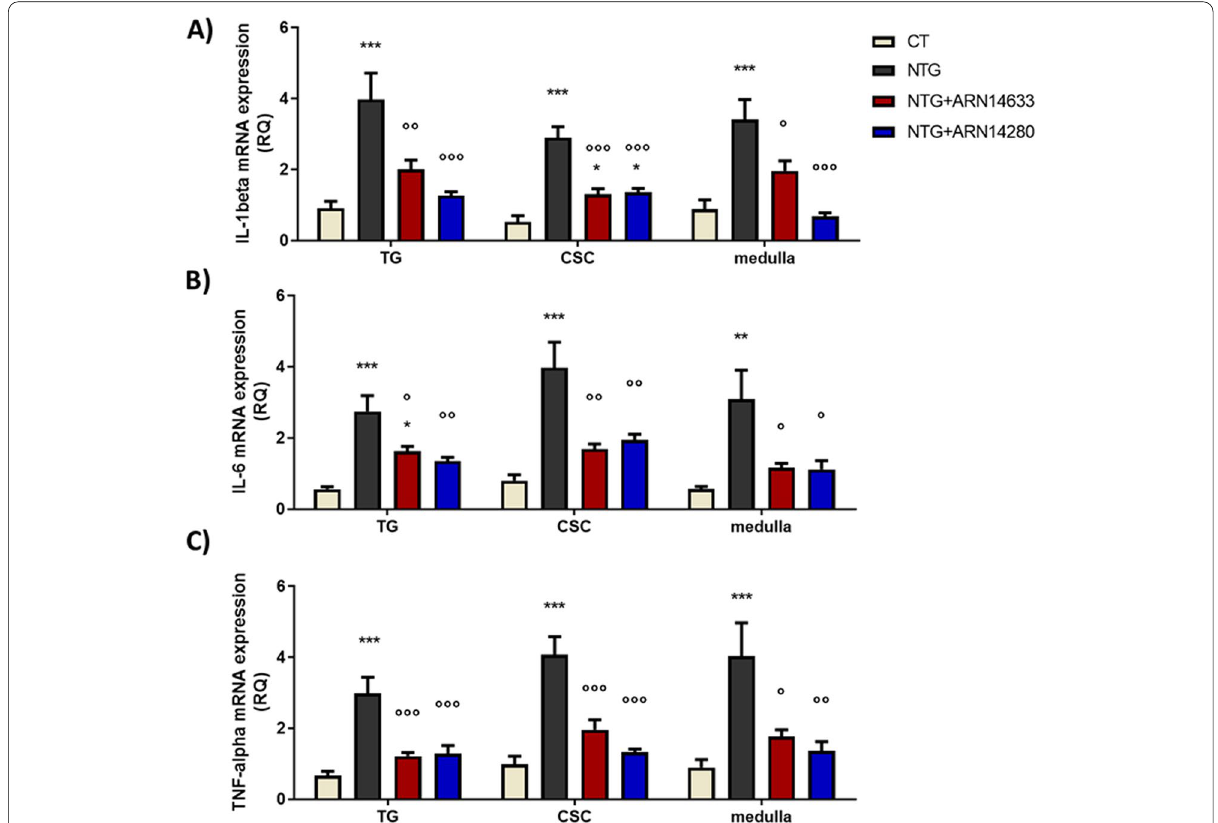
Fig. 5 IL-1beta ( A ), IL-6 ( B ) and TNF-alpha ( C ) mRNA levels (expressed as relative quantification, RQ) in trigeminal ganglion (TG) and cervical spinal cord (CSC) ipsilateral to formalin injection and medulla in toto of animals treated with NTG vehicle (CT), NTG, NTG NTG ARN14280 (n. 9 per group). Data are expressed as mean + ** p < 0.01 and *** p < 0.001 vs CT; ° p < 0.05, °° p < 0.01 and °°° p < 0.001 vs